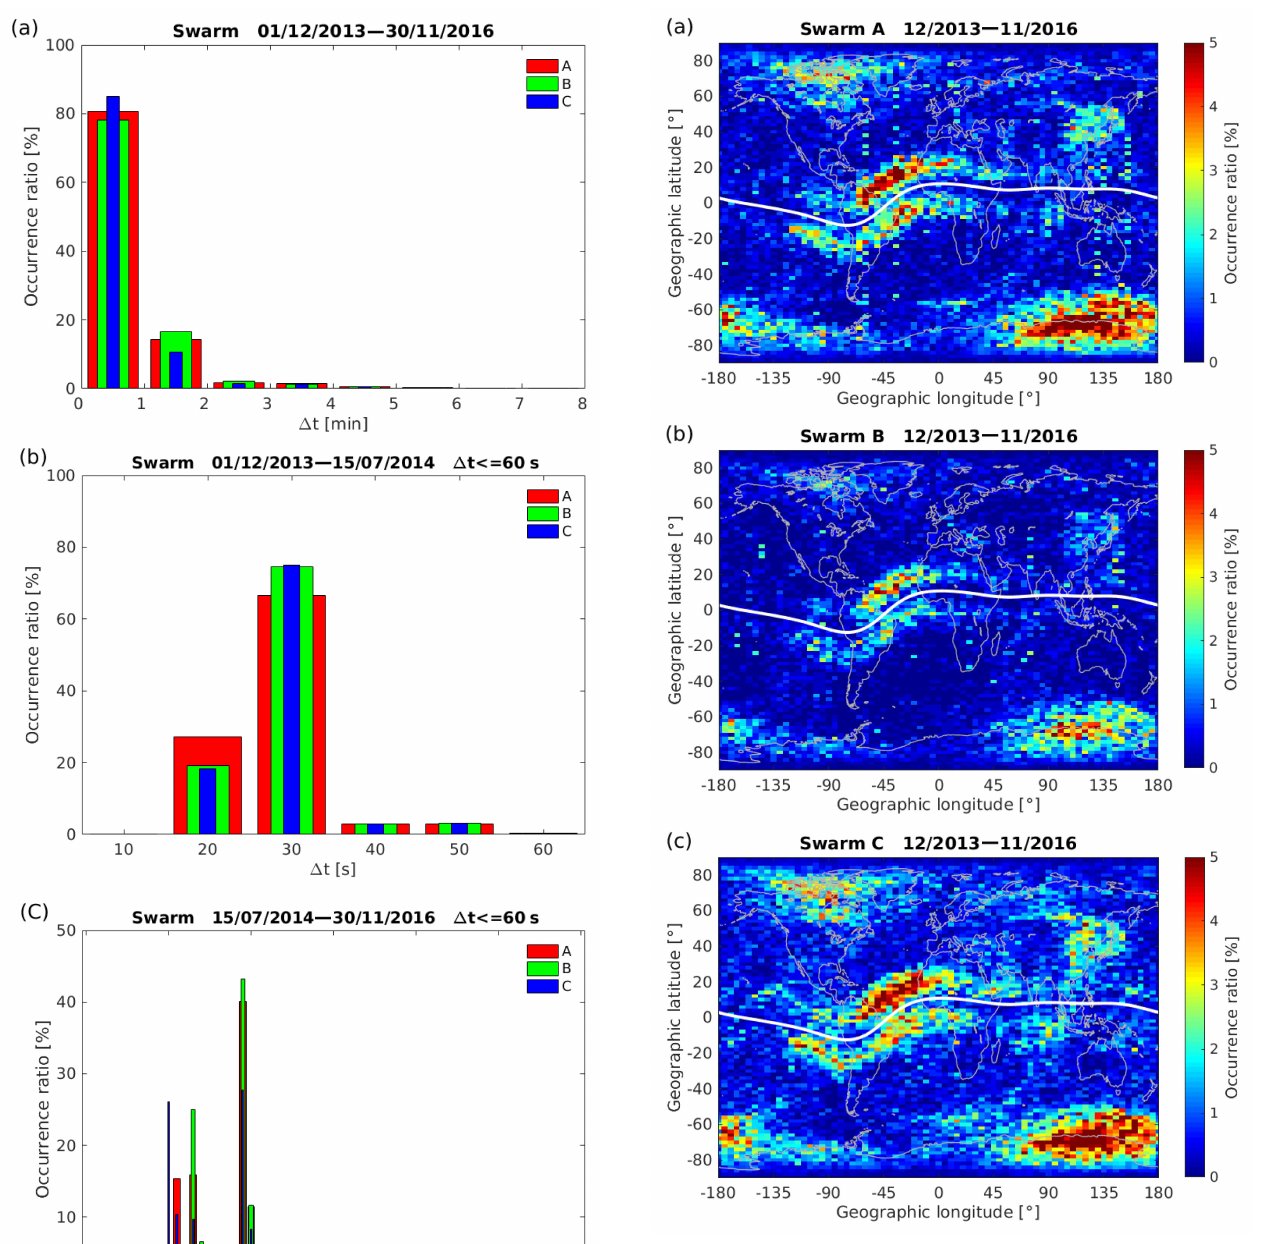
Figure 2. Global distributions of GPS signal loss events observed by three Swarm